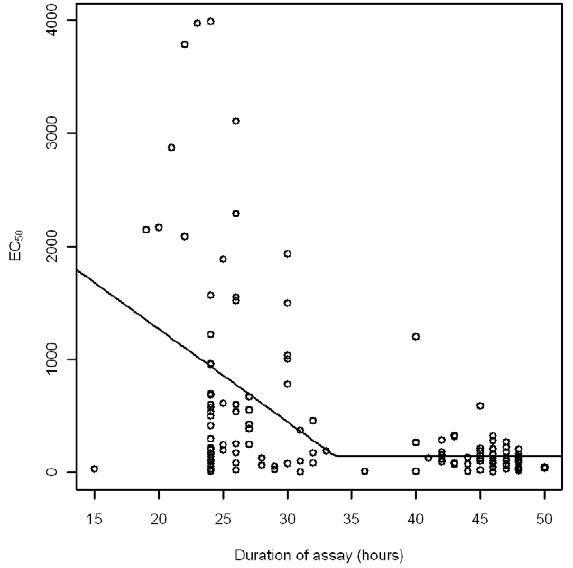
Figure 3. Threshold modelling results for the relationship between assay duration and estimated CQ EC 50 values in P. vivax .